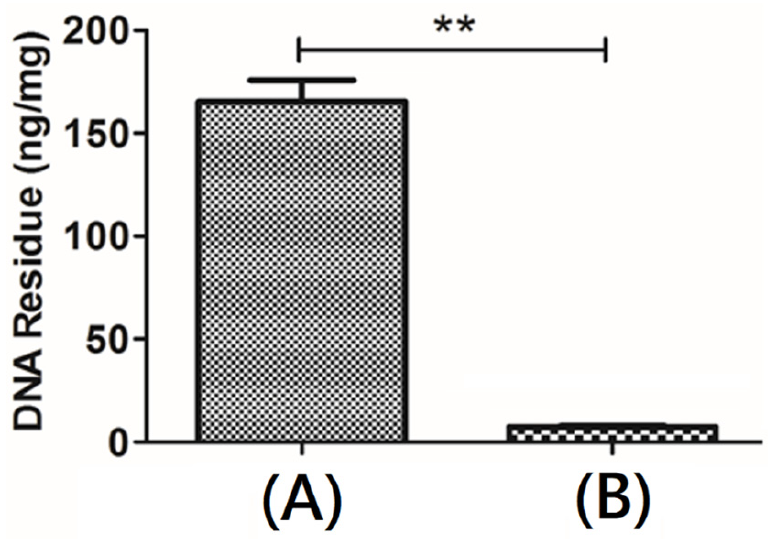
Figure 6. Quantitative DNA detection of ( A ) original porcine dermal and ( B ) decellularized bio-scaffold (Data are mean ± SD, n = 3; ** p < 0.01).